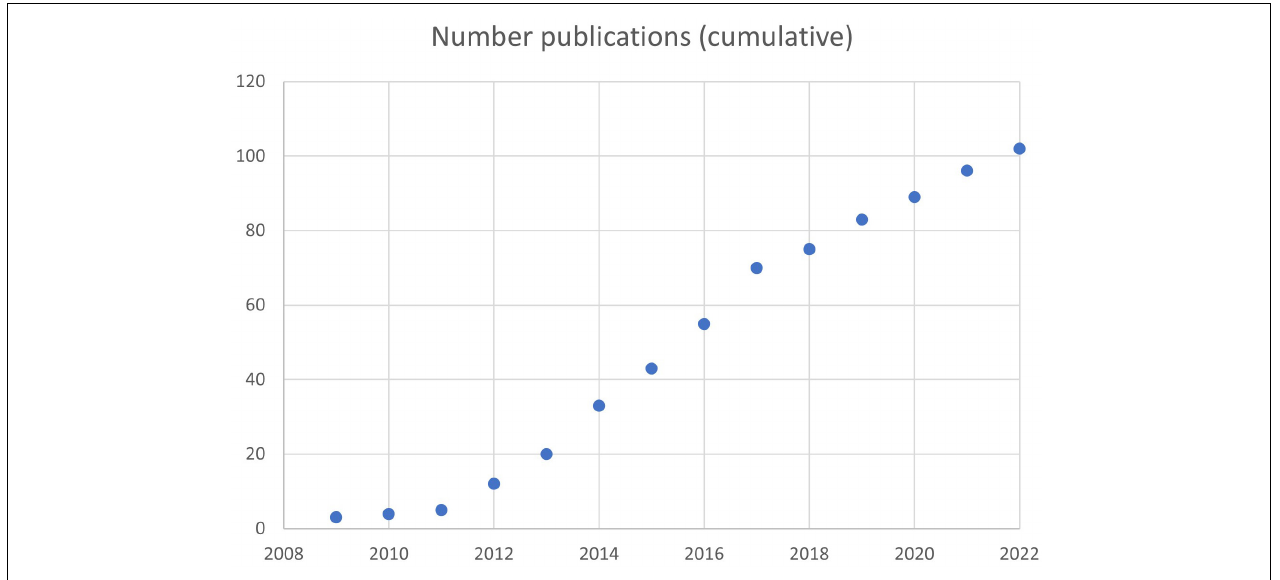
FIGURE 1 | Rate of publication of peer-reviewed articles based on NeuroQuant R (cid:13) . A total of 102 articles had been published by